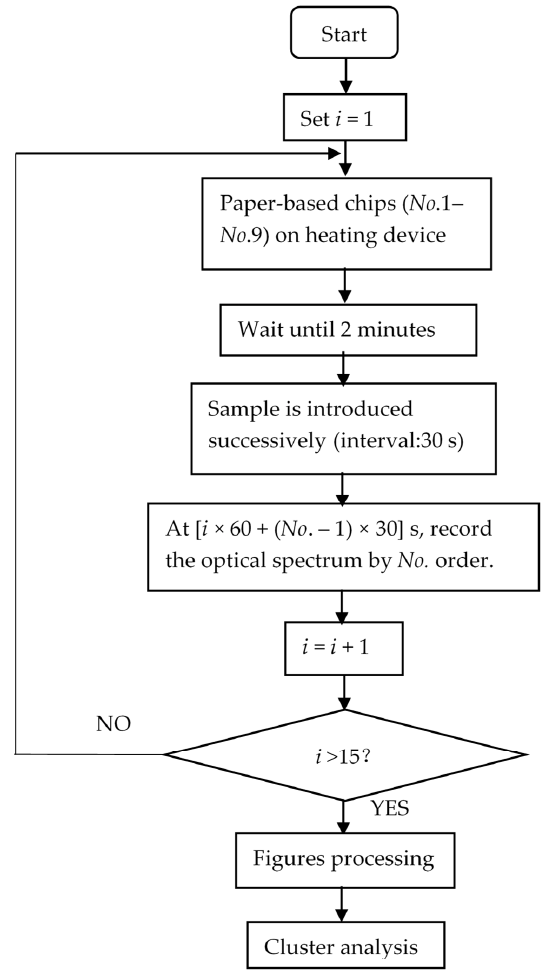
Figure 8. The flow chart of the pesticide identification assay via absorbance model and chromogenic molecules.